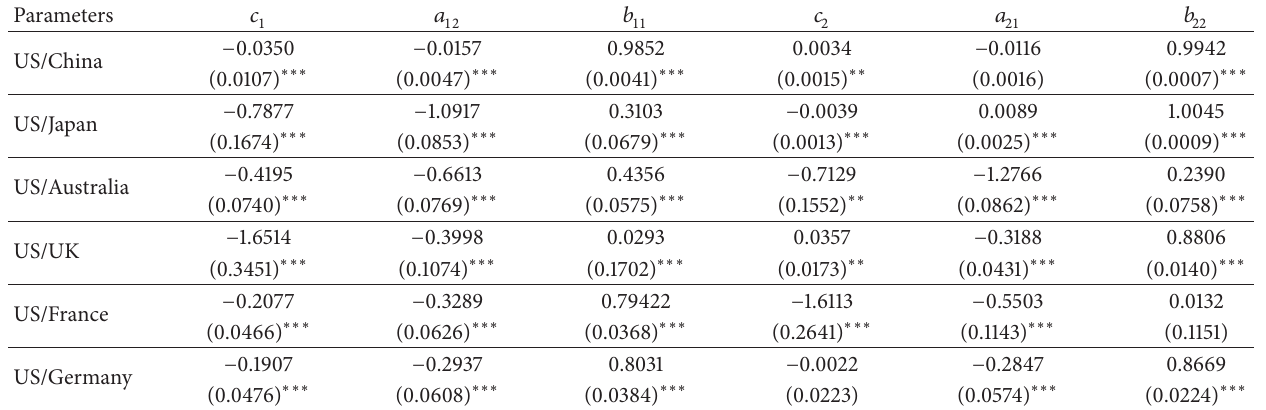
Table 2: Estimates of MV-CAViaR model for the overall